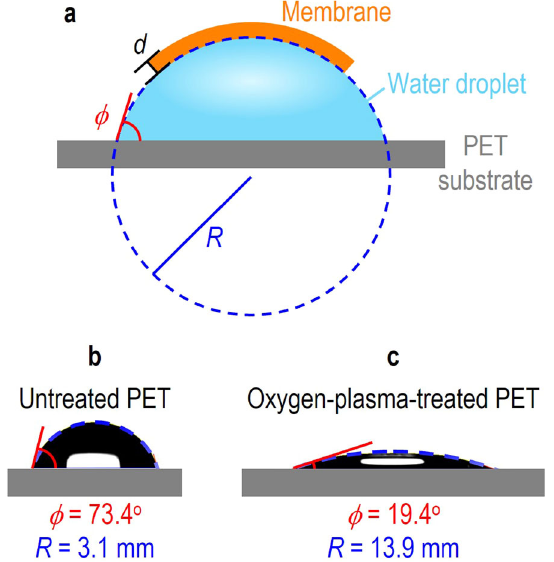
Fig. 3 Stress relaxation of the membrane on a water droplet. a Membrane fl oating on the water droplet is under stress; the associated stress is inversely proportional to the radius of curvature ( R ) and the membrane thickness ( d ). The contact angles ( ϕ ) between the water droplet and PET substrate decreased b from ~73.4° for untreated PET c to ~19.4° for oxygen-plasma-treated PET. Accord- ingly, the radius of curvature increased from 3.1 to 13.9 nm. Thus, we can transfer much thinner membranes with a clean surface and a wide area on oxygen-plasma-treated PET